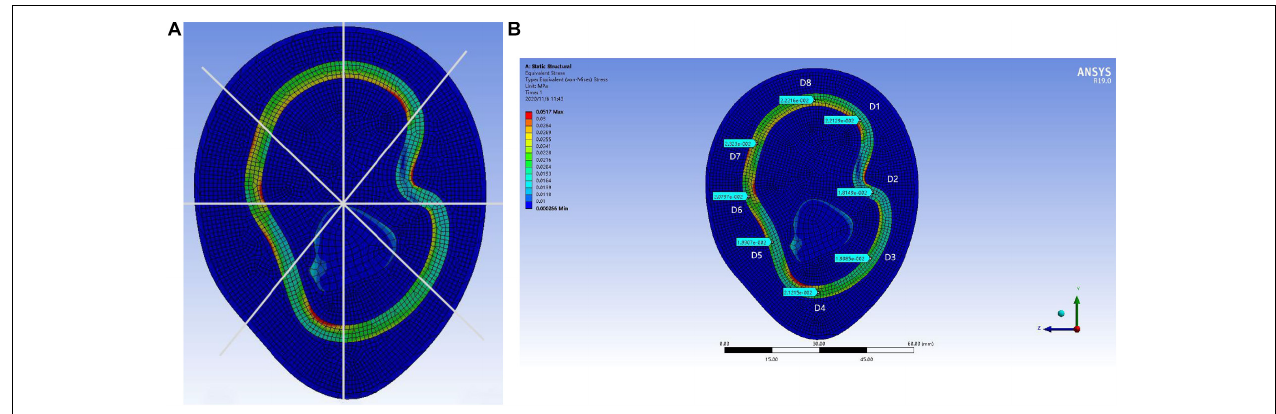
FIGURE 12 | Display of point selection and positioning method of “ -shaped” line mark: (A) “ -shaped” line mark and (B) 0.004 MPa external pressure value of “ -shaped” line mark pressure.